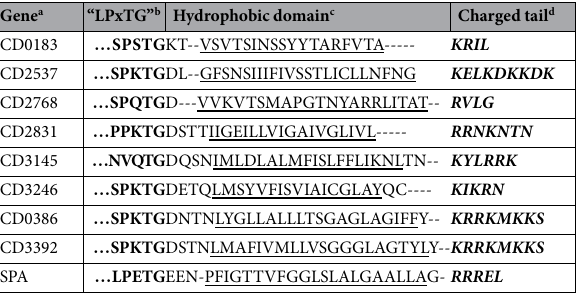
Table 1. C-terminus analysis of putative sortase substrates in C . difficile . a Genes and corresponding proteins are from strain 630 (top) and from S . aureus Protein A (SPA); b–d the conserved LPXTG motif (bold), the hydrophobic domain (underlined) and the positively charged tail (italics, bold) are